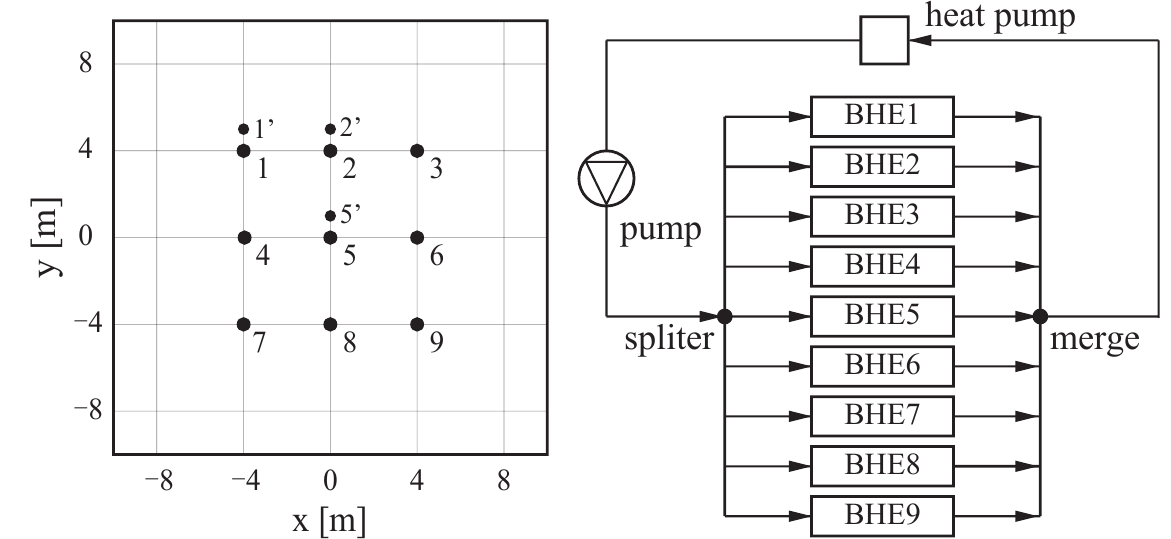
Figure 7. Location of the MSBHEs in the subsurface model.